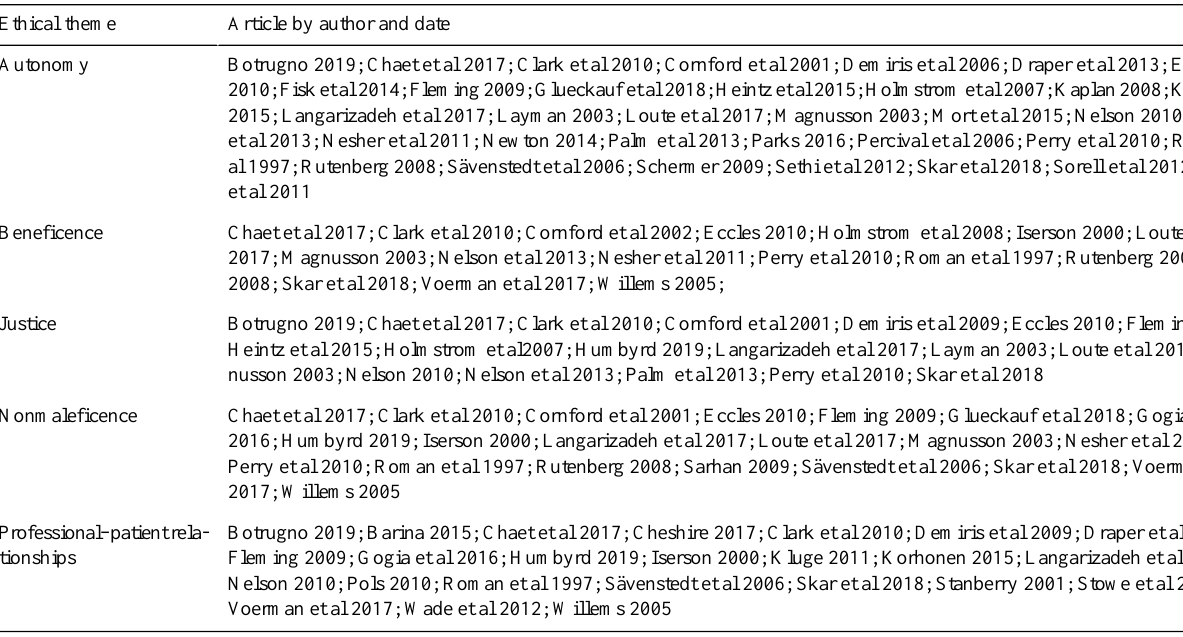
Table 1. Summary of themes and distribution of the discussion by